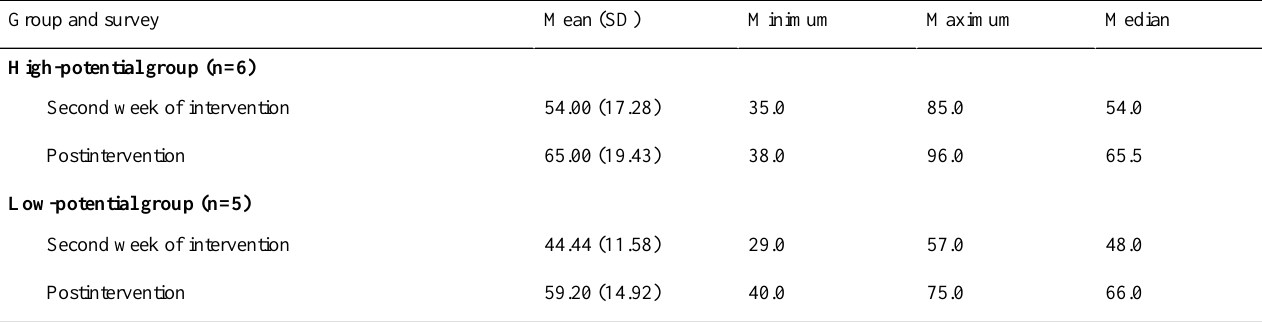
Table 4. Scores of the modified Computer Self-Efficacy Scale (mCSES) from the second-week and postintervention surveys for the high-potential and low-potential groups